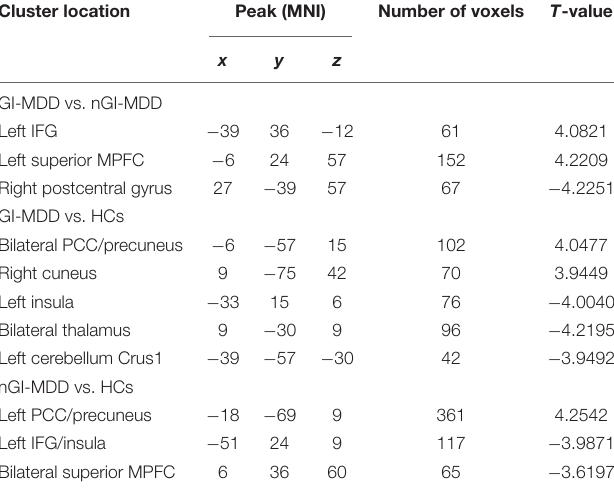
TABLE 2 | Significant PAS differences across